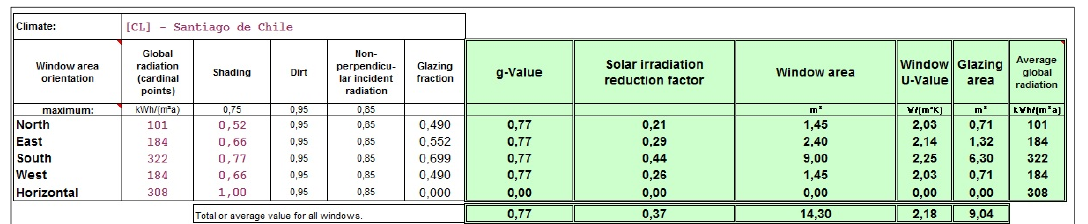
Figure A4. Thermal Bridges.